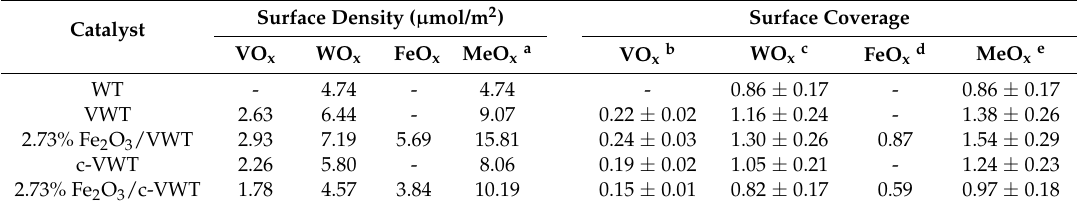
Table 2. Surface density and surface coverages of the active ingredients in V 2 O 5 /TiO 2 -based